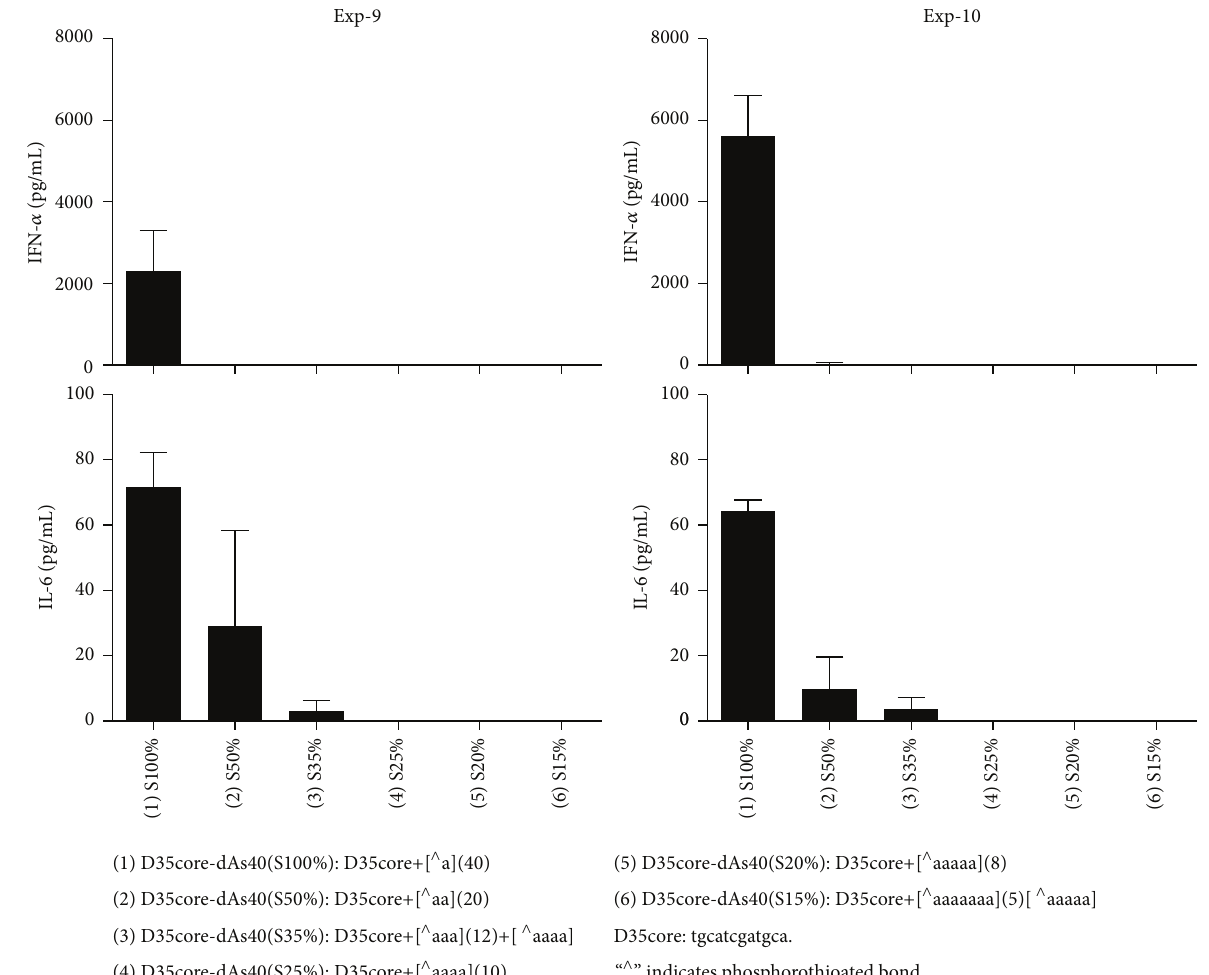
Figure 6: Phosphorothioation amount of the tail affects ODN’s immunostimulatory activities. Human PBMCs were stimulated with the indicated synthetic ODNs (1 𝜇 M) for 24 hours. IFN- 𝛼 and IL-6 production in the supernatants were examined by